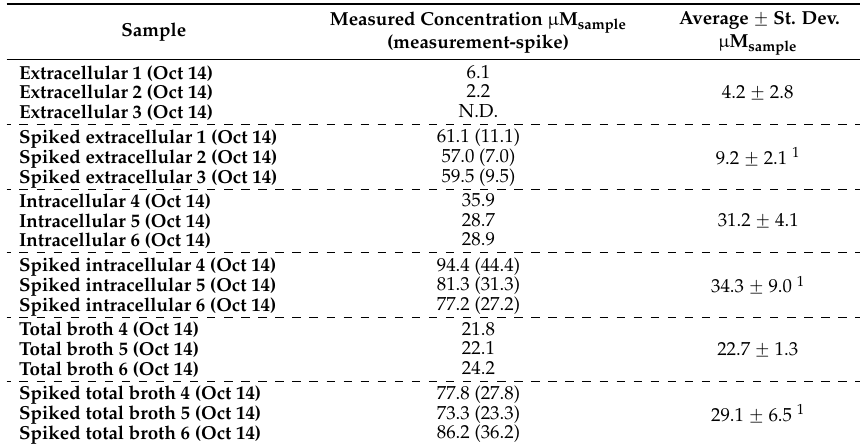
Table 1. Results of the spike experiments using cold-buffered chloroform-methanol extraction (CM5) as extraction method. The estimated concentration when the spiked amount (50 µ M) is subtracted from the measurement is shown in brackets. The results are displayed as µ M sample . The results are single injections of independent